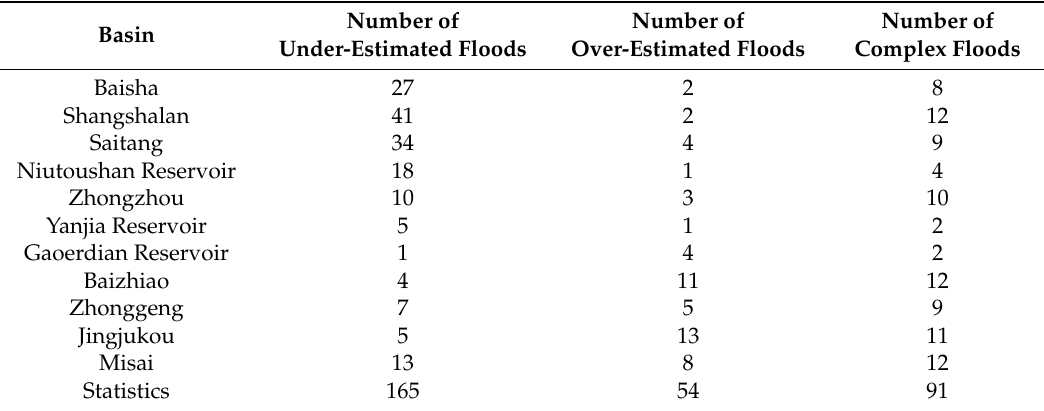
Table 11. Flood type statistics of each basin.